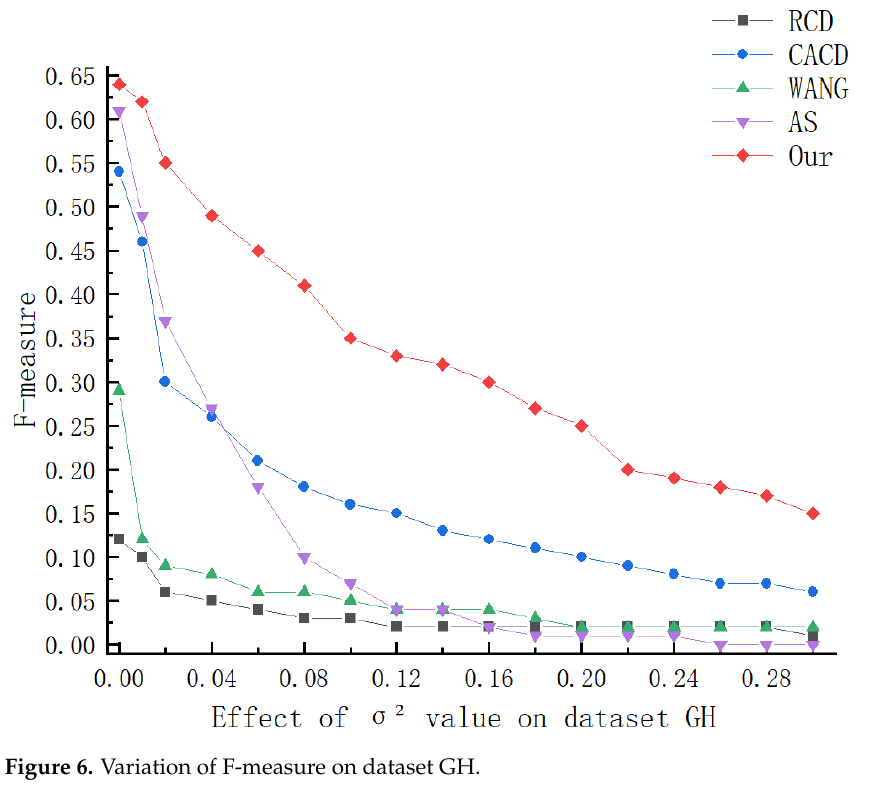
Figure 6. Variation of F-measure on dataset GH.